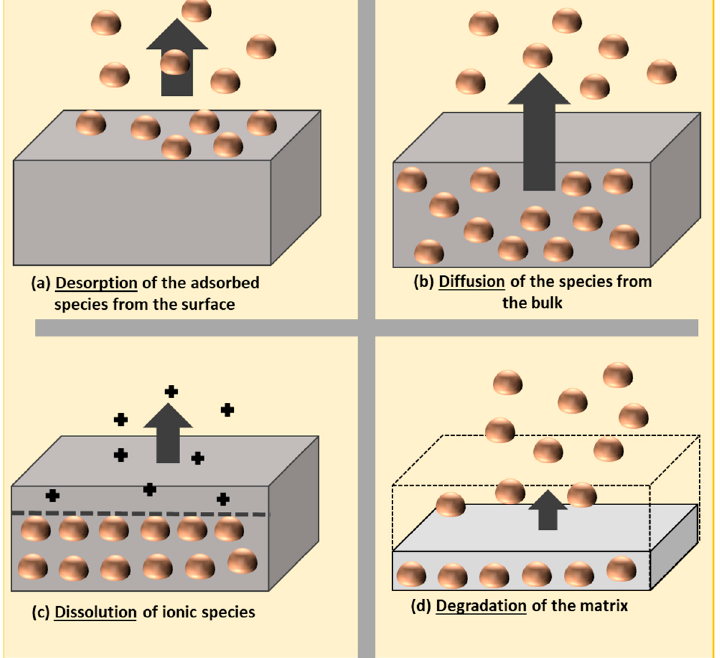
Figure 8. Potential release pathways, known as “the 4Ds”: desorption, diffusion, dissolution, and degradation of engineered nanomaterials from polymer nanocomposites, as proposed by Noonan et al. [171].